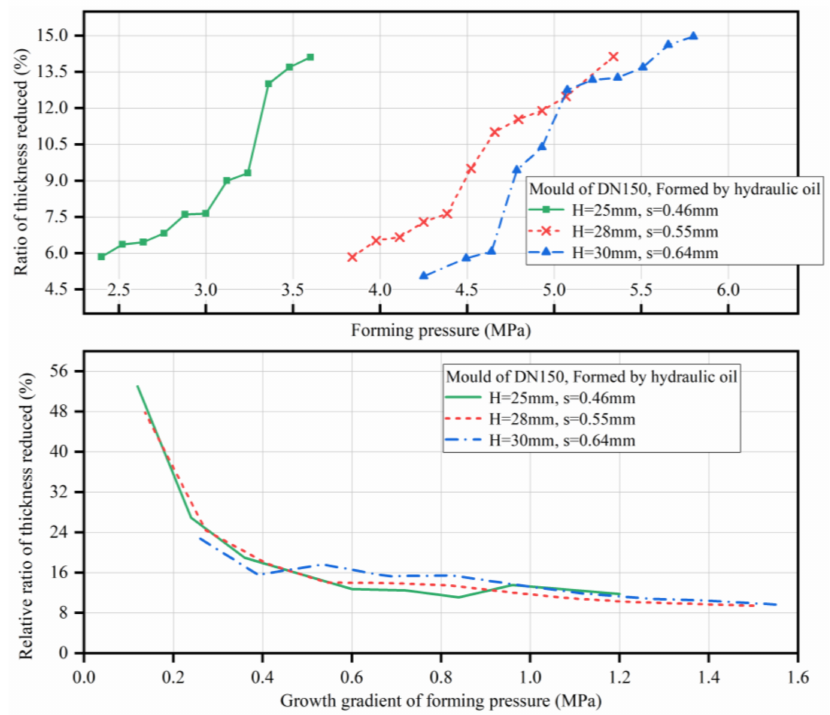
Figure 18. Absolute and relative ratios of thickness reduction for Dn 150 mm rupture discs formed by hydraulic oil.